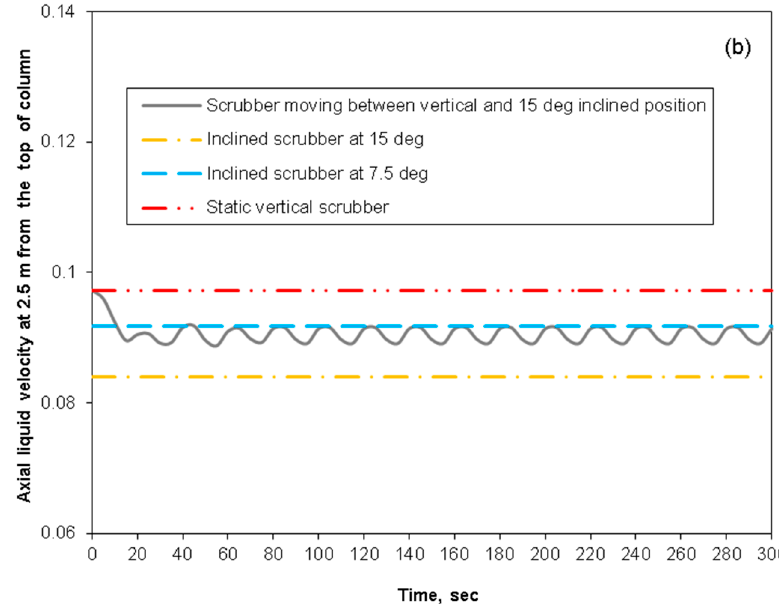
Figure 22. Time-dependent cross-sectionally averaged liquid holdup ( a ) and liquid axial velocity ( b ) in a seawater scrubber under angular sinusoidal oscillatory motion between the vertical and an inclined (15°) position (Packed-bed column with Raschig super-Rings; H = 5 m; z/H = 0.5; Pressure = 1.5 MPa; Travel time between the vertical/inclined and inclined/vertical positions = 10 s).